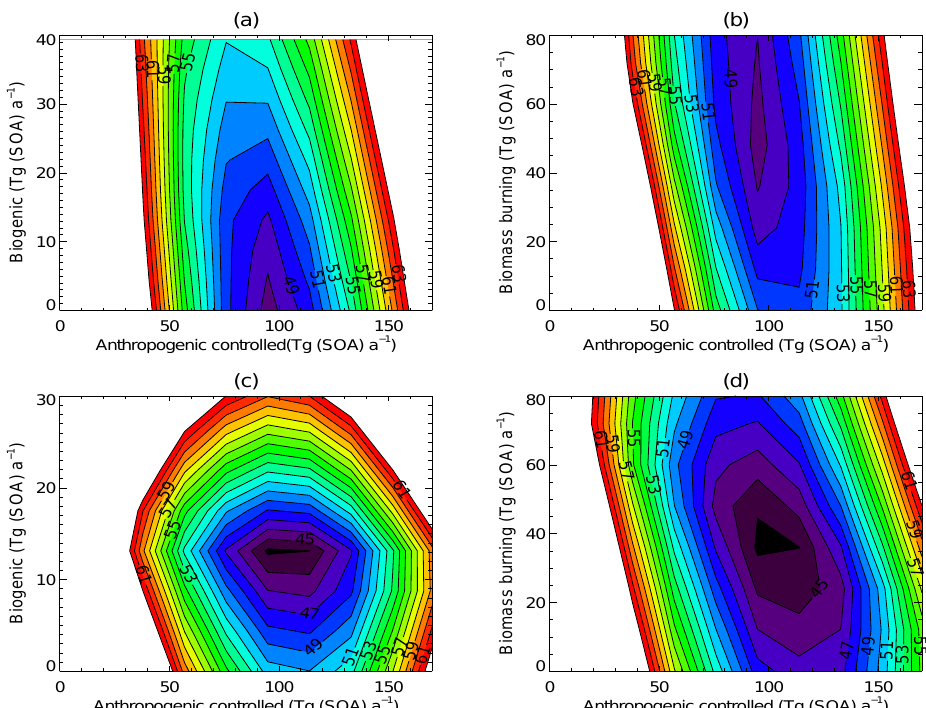
Fig. 5. Normalised mean error (NME, %) between SOA simulated by a linear version of the global model and OOA observed by the AMS as a function of (a) and (c) biogenic (isoprene and monoterpene) and anthropogenically controlled SOA (biomass burning SOA fixed at 36Tg(SOA)a − 1 ) ; (b) and (d) biomass burning and anthropogenic controlled SOA (biogenic SOA fixed at 13Tg(SOA)a − 1 ) . In panels (c) and (d) AMS observations have been weighted to remove bias in the observational dataset as described in Sect. 3.2.